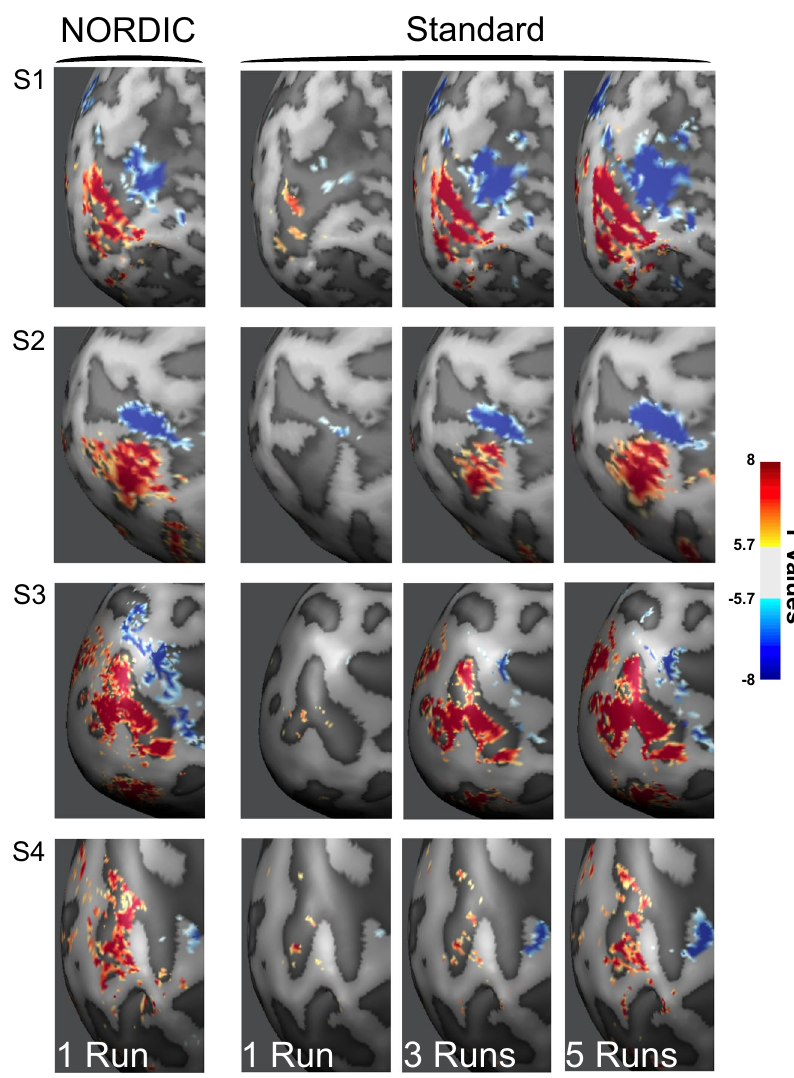
Fig. 2 NORDIC vs. Standard t -Maps. Leftmost panel shows functional images as t -maps (target > surround) thresholded at | t | ≥ 5.7 for a single NORDIC processed run, and for 1, 3, and 5 Standard processed runs combined, for subject 1 (S1), subject 2 (S2), subject 3 (S3) and subject 4